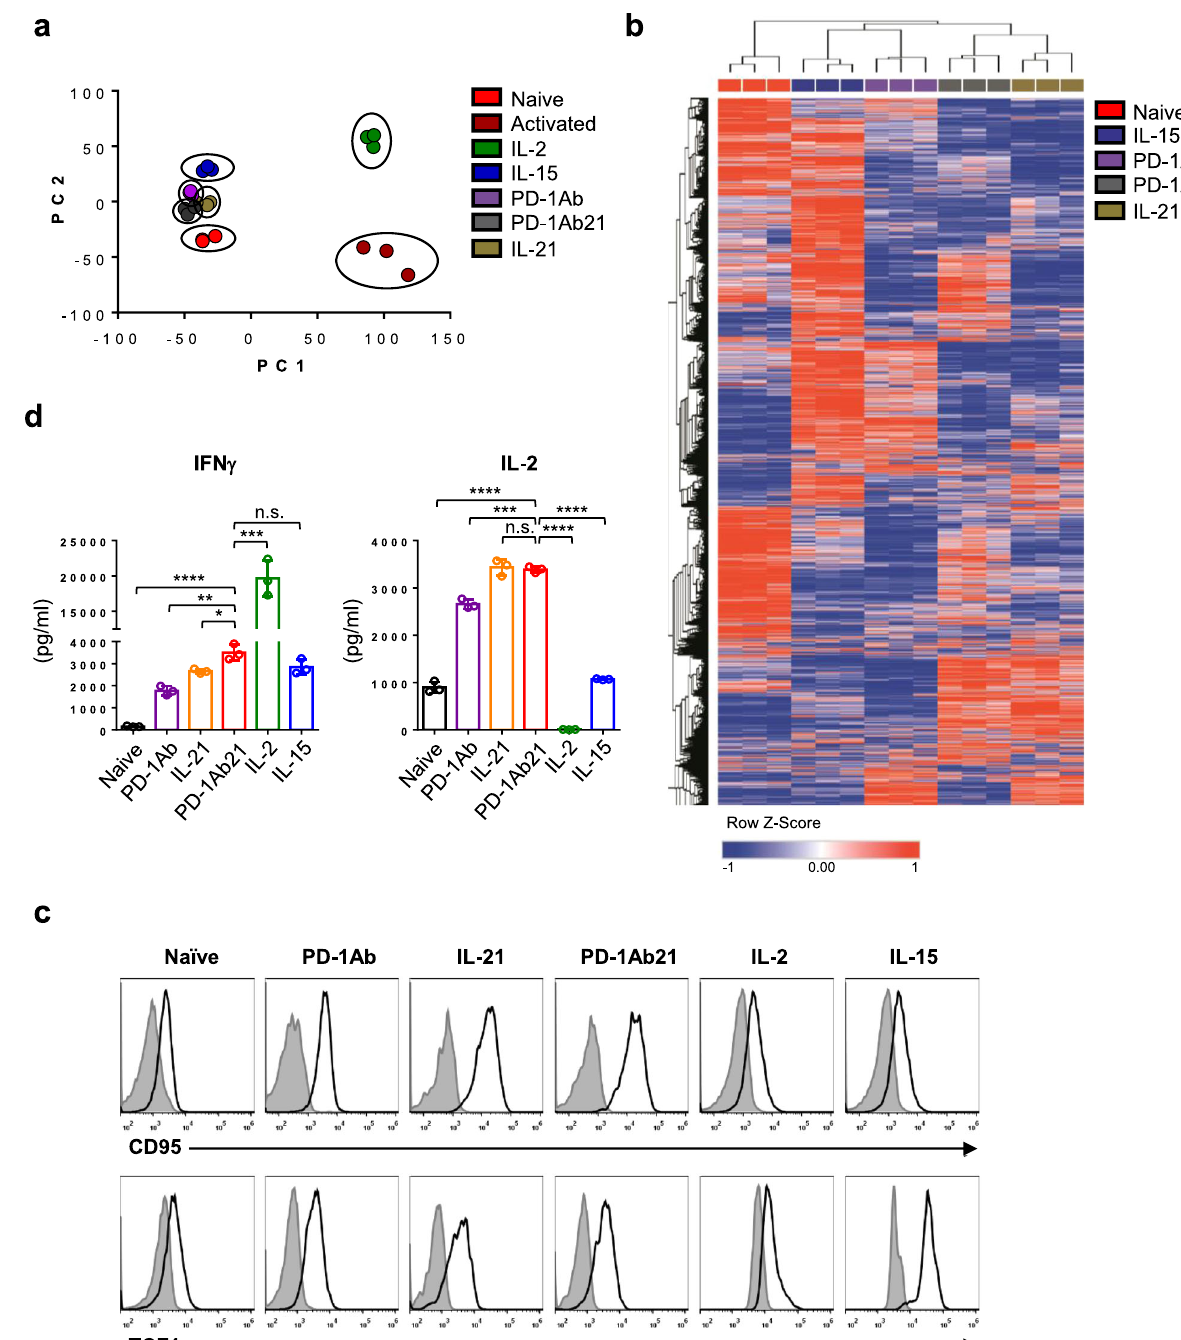
Fig. 3 Analysis of transcriptome pro fi le and functions of PD-1Ab21-induced naïve-like T cells. a , b RNA-seq was performed in sorted T N , activated CD44 high CD62L high , PD-1Ab21-generated CD44 low CD62L high and IL-15 or IL-2-differentiated cells. a Principal component analysis (PCA) of T cell subsets based on the global transcriptome (~10,000 genes), ( n = 3 samples for each cell population). b Heatmap showing the z-transformed expression values of library size-normalized read counts for each differentially expressed gene, colored from blue to red. RNA-Seq data from each independent sample are shown in the columns. Comparisons of gene expression between each pair of CD8 + T cell subsets were done by DESeq2 analysis (Benjamini – Hochberg adjusted P -value < 0.01, fold change > 2). c Flow cytometry analysis for expression of Fas and TCF1 in T N and cells differentiated with different proteins. The isotype ( fi lled histogram) and anti-CD95 (top) or anti-TCF1 (bottom) (open histogram) antibody staining are shown. d Cytokine production of T cells. T cell subsets were sorted as described in a , and stimulated with PMA/ionomycin for 4 h. IFN- γ and IL-2 in the supernatants were detected by ELISA. The data are presented as mean ± SEM and are representative of at least three independently performed experiments. Results were compared by unpaired two- tailed t -test. d * p = 0.0165, ** p = 0.0019, *** p = 0.0004 (left and right panel), **** p < 0.0001, n.s. not signi fi